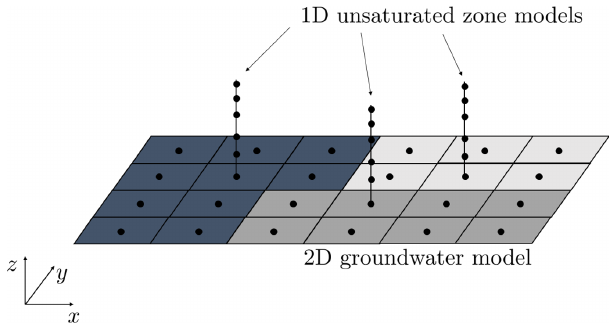
Figure 1. Example of the coupled model grid with three recharge zones (white, gray and